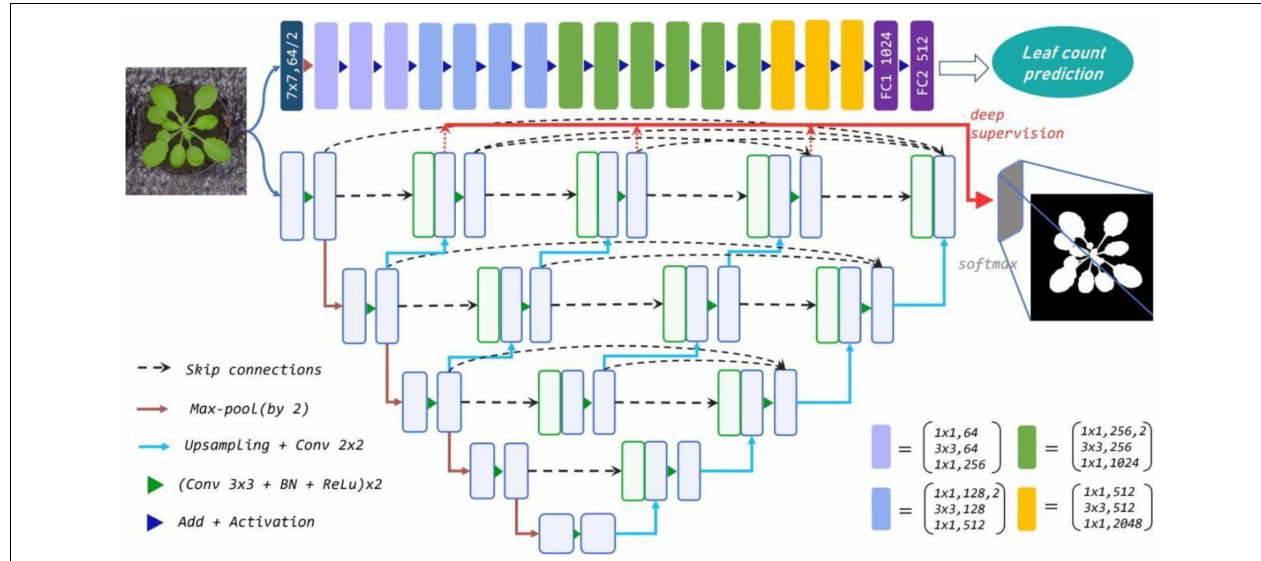
FIGURE 1 | The proposed parallel two-stream network combines leaf counting and segmentation tasks. Top row: the modified Resnet50 regression model for leaf counting with 16 residual blocks. Remaining rows: U-Net++ for segmentation via multi-use of the features from different semantic levels (layers). Each blue box corresponds to a multi-channel feature map, and the green boxes represent copied feature maps. The arrows denote various